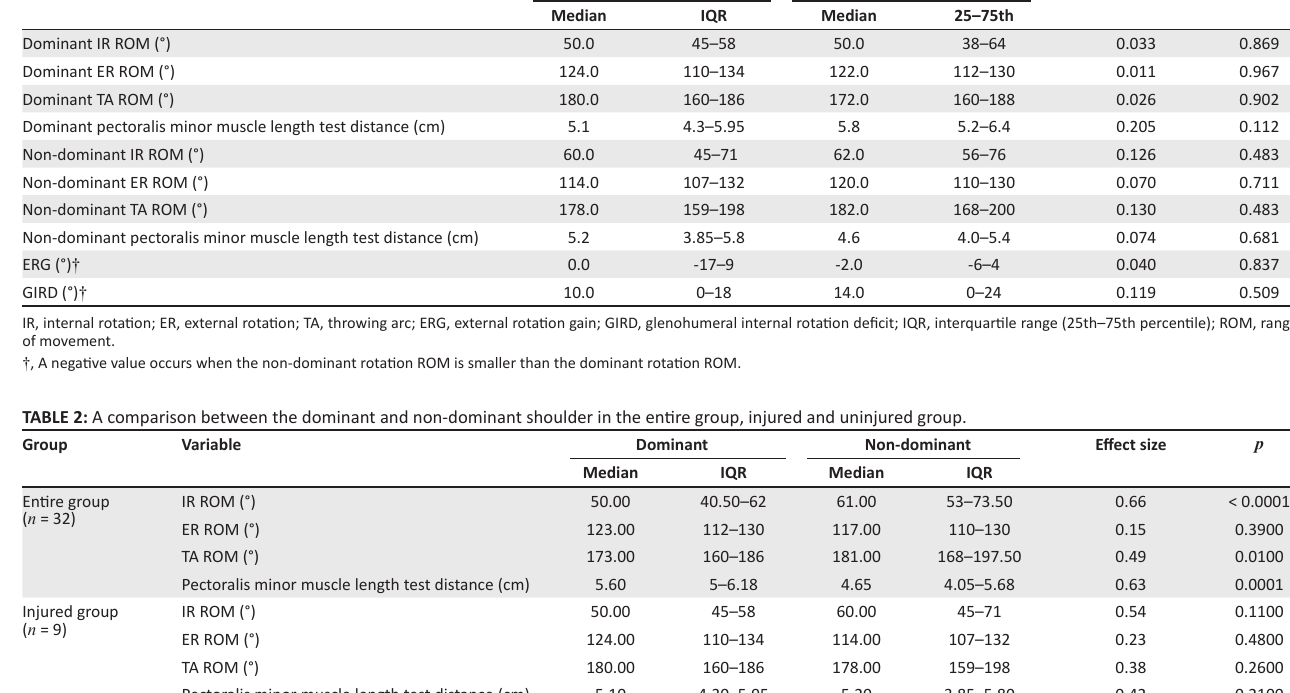
TABLE 1: A comparison between the injured and uninjured group. Variable